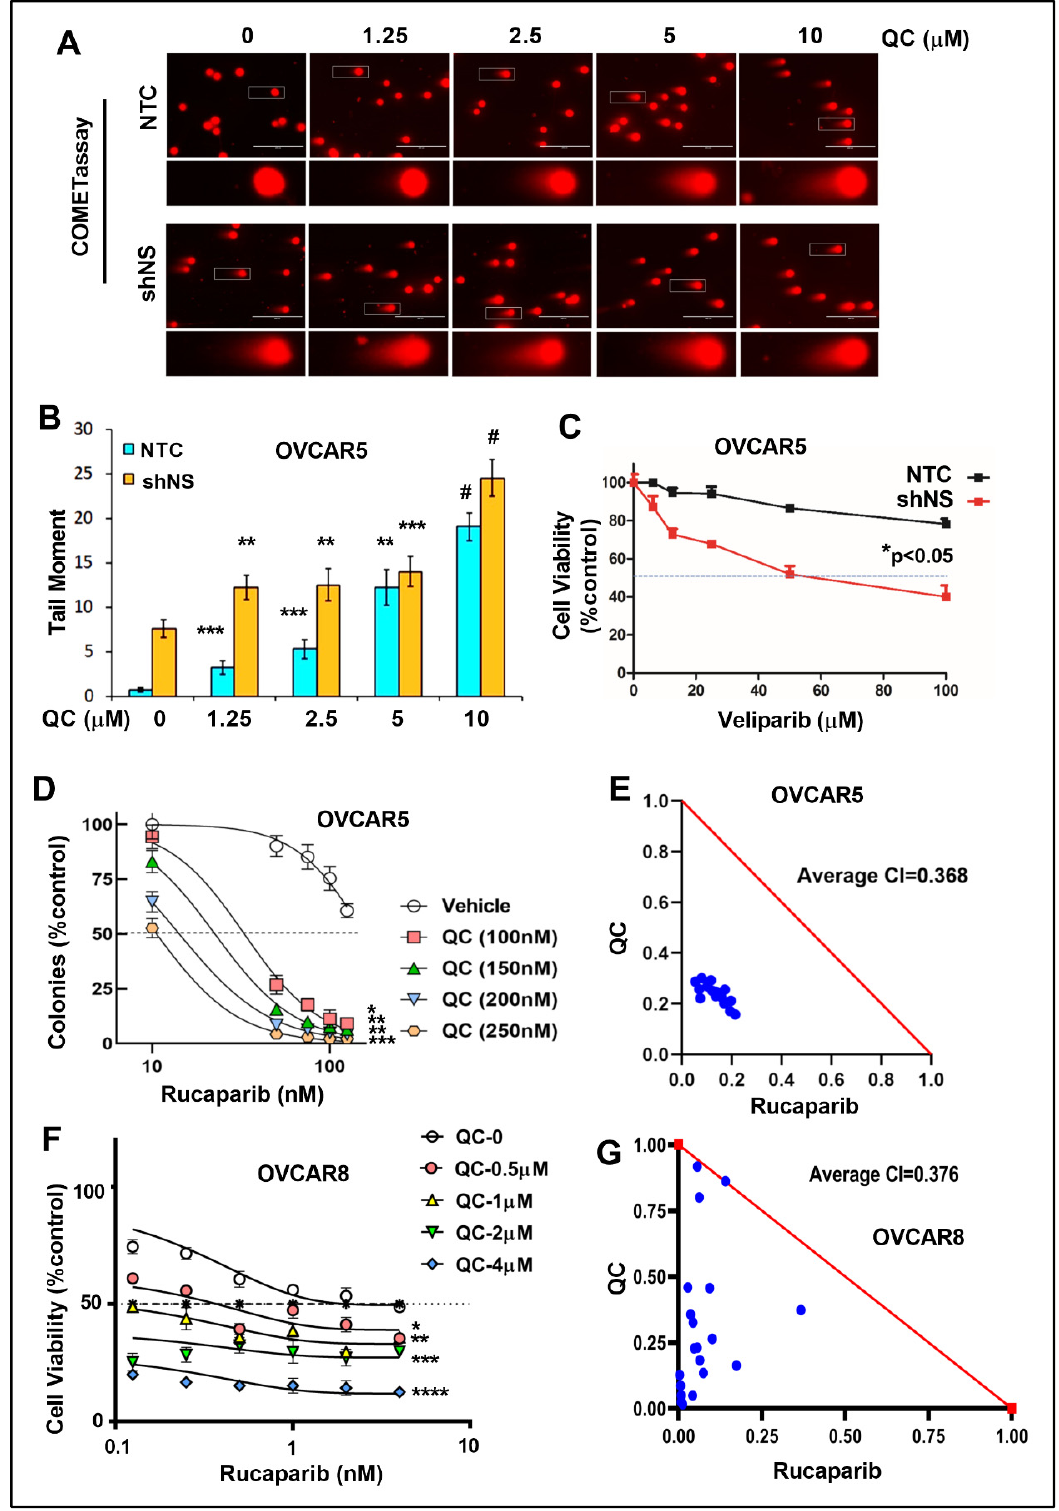
Figure 6. NS knockdown cells are sensitized to QC-induced DNA damage and QC sensitizes OC cells to PARPi. ( A ) Alkaline COMET assay shows increase in DSDBs following QC treatment in both OVCAR5 NTC and NS KD cells. ( B ) Quantified tail moment from the COMET assay was represented ** ( p < 0.001), *** ( p < 0.0001), # ( p < 0.00001). ( C ) Cell viability was assessed in both NTC and NS KD cells upon dose dependent Veliparib treatment using MTT assay. ( D ) Colony formation assays using OVCAR5 cells upon treatment with indicated concentrations of QC alone or in combination with